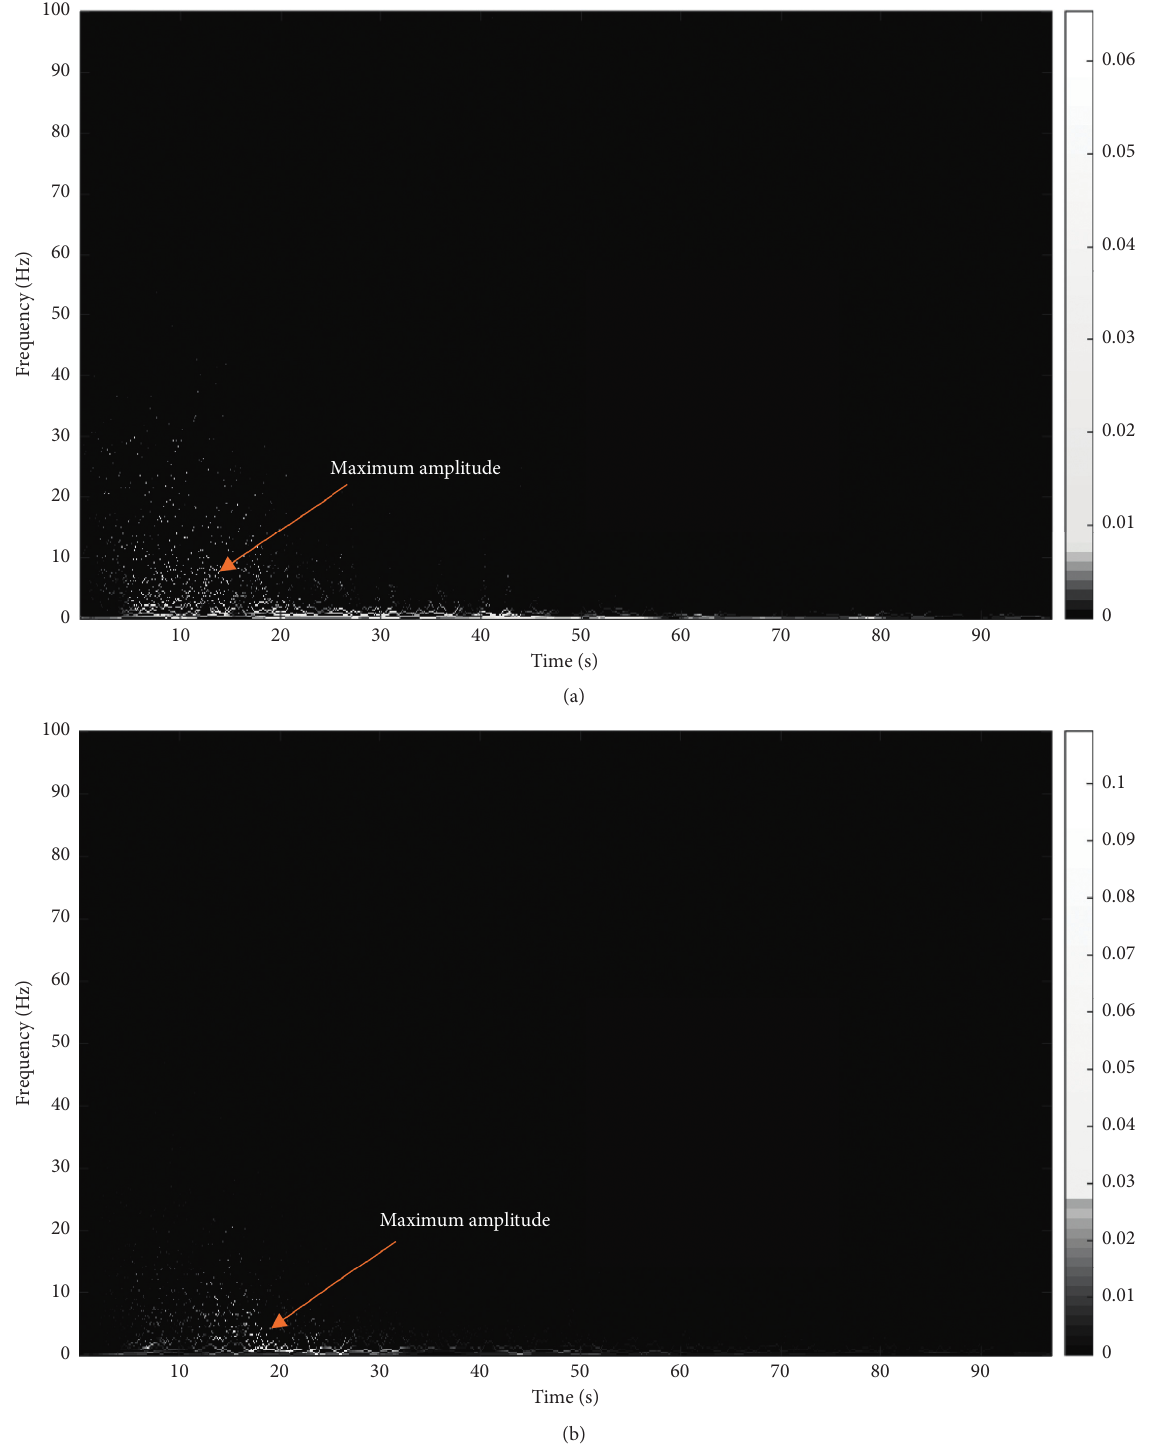
Figure 9: Hilbert–Huang spectrum for two earthquake time histories. (a) Hilbert–Huang spectrum for silt layer ( V bert–Huang spectrum for silty clay layer ( V s �